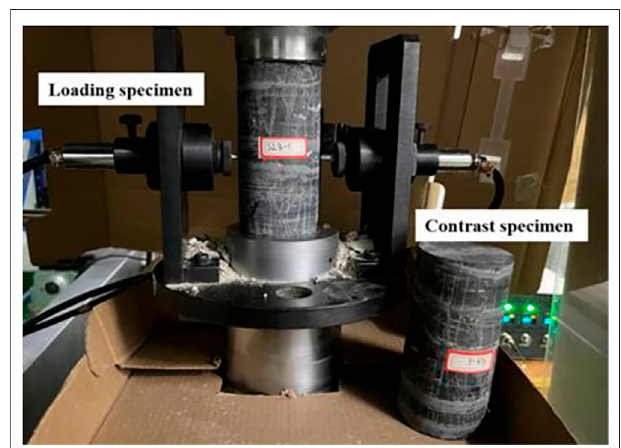
FIGURE 4 | Comparison of loading phosphorite specimens and reference